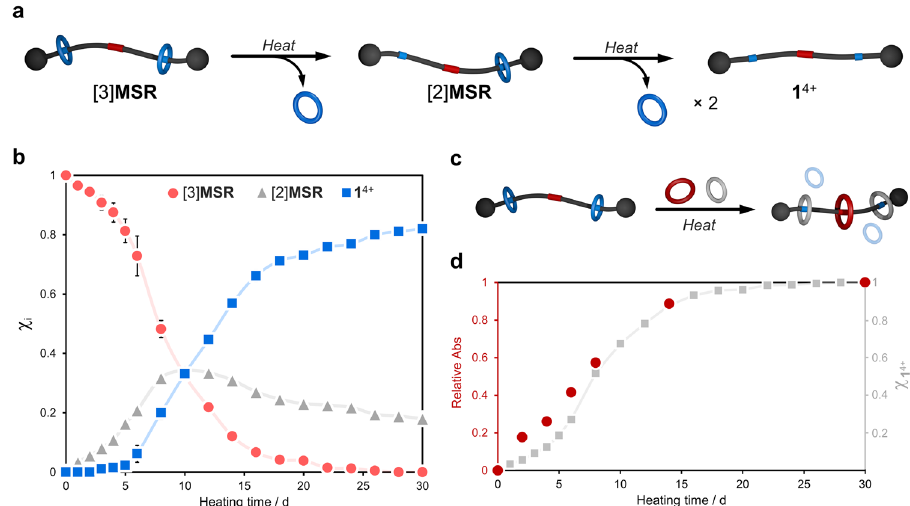
Fig. 3 Dissociation process for [3]MSR. a Schematic representation of the stepwise disassembly of [3] MSR . b Speciation plot showing the appearance of [2] MSR and 1 4 + to the detriment of [3] MSR . Data extracted from 1 H NMR spectra (Supplementary Note 1). Error bars correspond to the standard deviation of three independent experiments. c Cartoon representation of a two-by-three ring-exchange involving [3] MSR , DB24C8, and DN38C10. d Relative absorbance changes at the CT band (486 nm) throughout the ring-exchange process (red). The gradual release of 1 4 + via the disassembly of [3] MSR is shown here for comparison